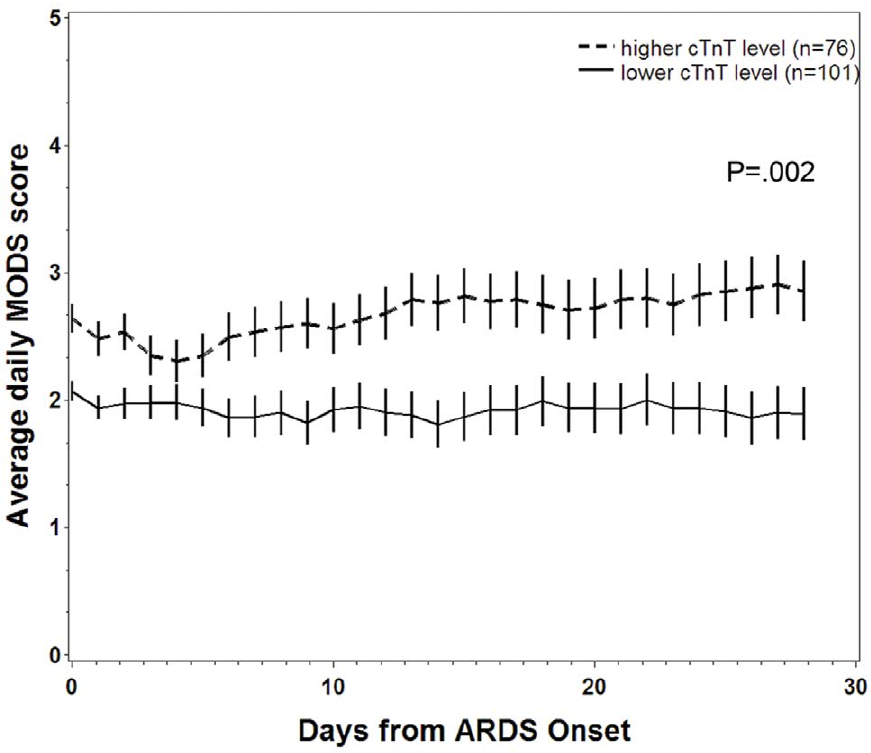
Figure 3. Daily MODS score by cTnT stratum. (Vertical bars indicate standard error of means, P value stated for repeated-measures ANOVA).